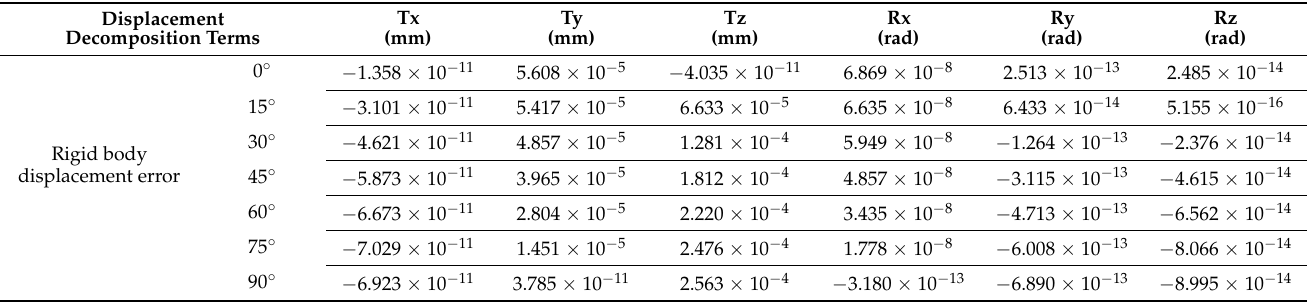
Table 6. Rigid body displacement error of L1S1.